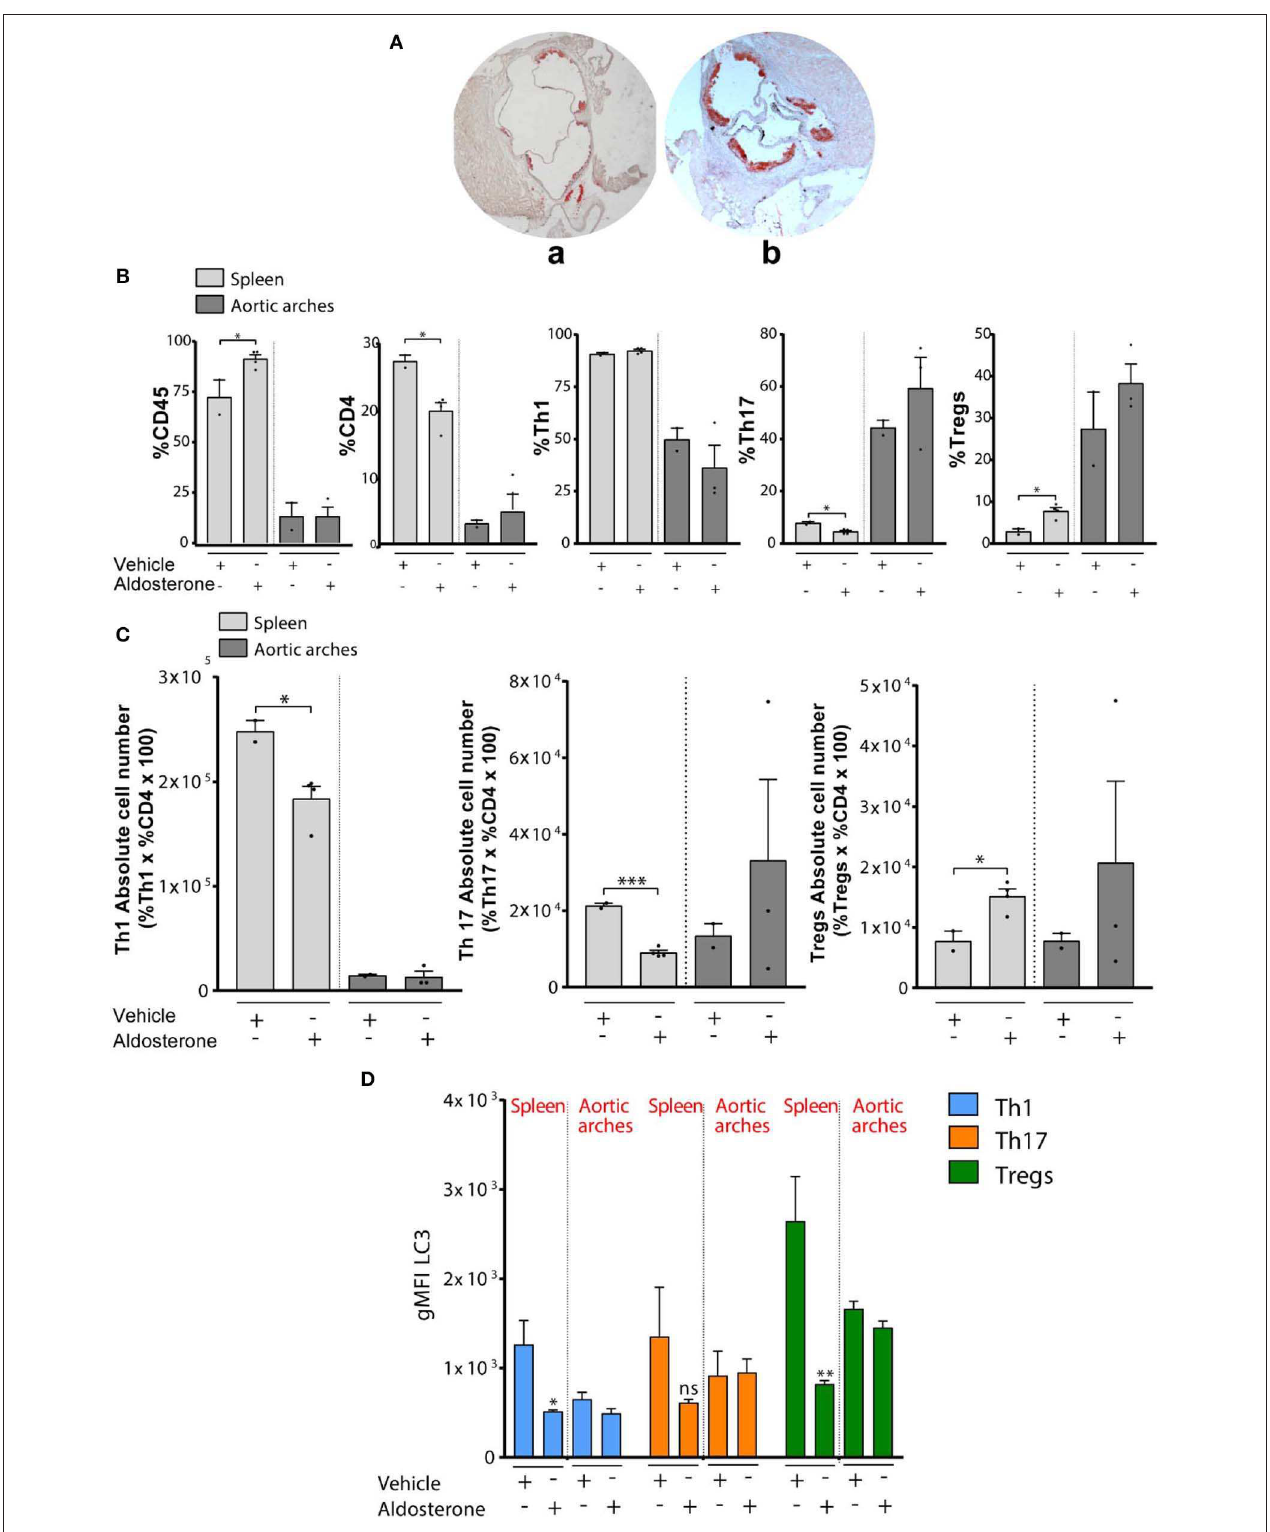
FIGURE 2 | (A) Quantification of atherosclerotic plaque composition in vehicle- or aldosterone-treated ApoE-KO: Representative Red Oil O stained cross sections of aortic root in 8- to 10-week-old ApoE-KO mice treated with vehicle (a) or aldosterone (6 µ g/mouse/day) (b) and fed an atherogenic diet for 4 weeks. (B) Percentage